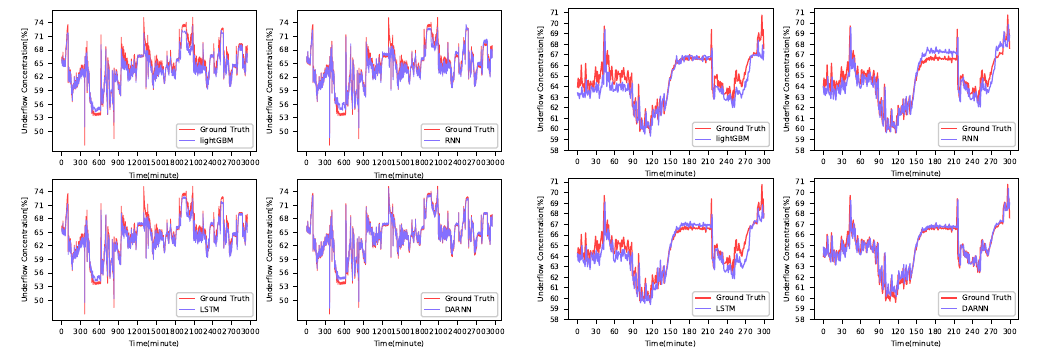
( b ) A sub interval of test dataset with 300 data points.